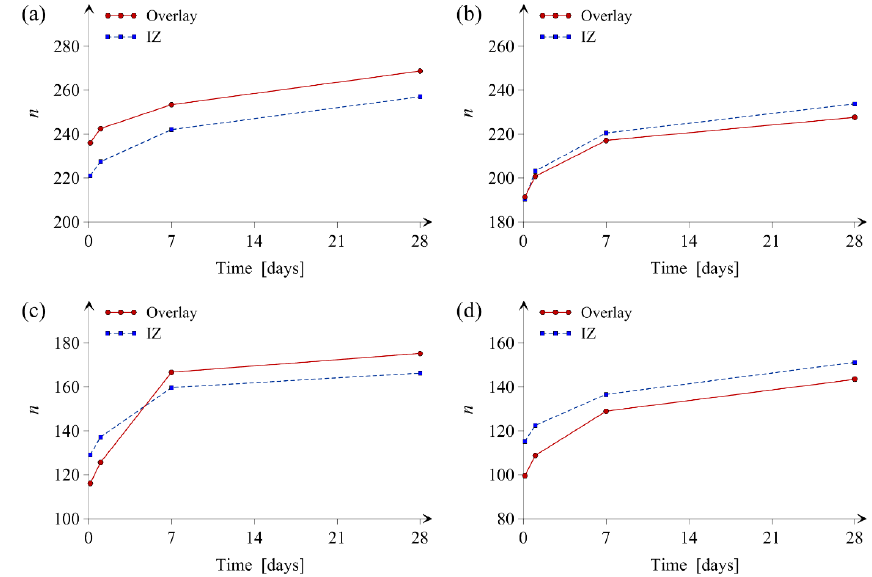
Figure 10. The average number of pores n as a function along a sample height obtained for the concrete within the IZ between the overlay and the existing concrete substrate obtained using the micro ‐ CT method at different moments of overlay hardening for Samples ( a ) T1; ( b ) T2; ( c ) T3; and ( d ) T4.